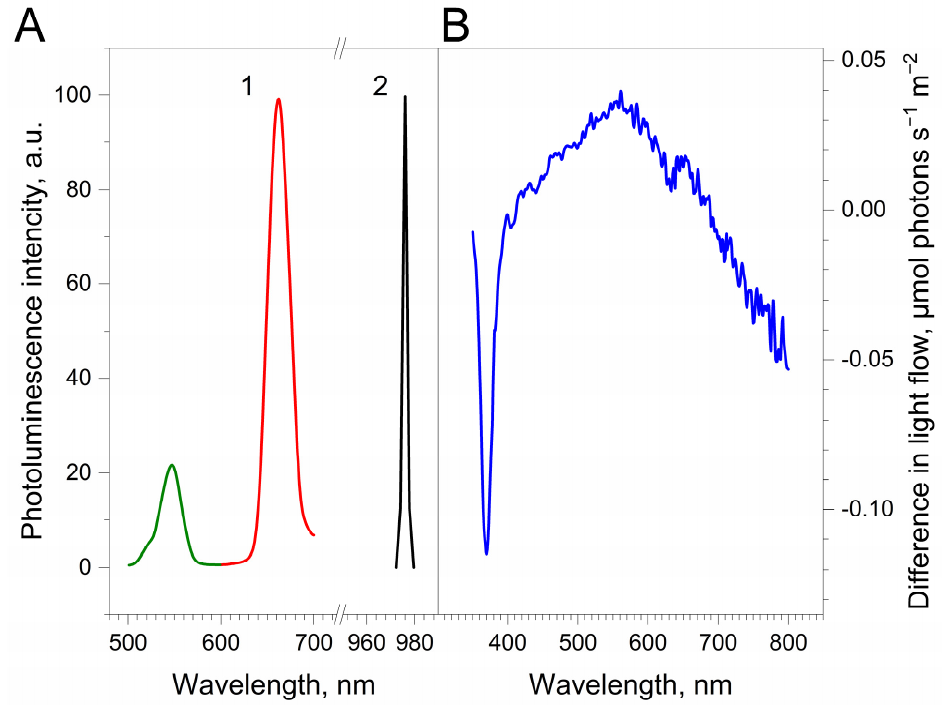
Figure 3. ( A ) Photoluminescence ( 1 ) of the nanoparticles in acetone in PAR range, which was excited by a semiconductor laser ( 2 ). ( B ) Difference spectrum (“light spectrum under photoconversion film” minus “light spectrum under common film”), showing changes in the spectrum of growth light. In figure ( A ), green and red colors indicate the luminescence in the green and red regions of the spectrum, respectively.